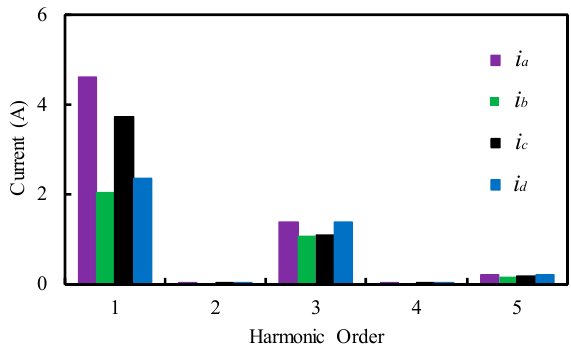
Figure 13. FFT of the currents.